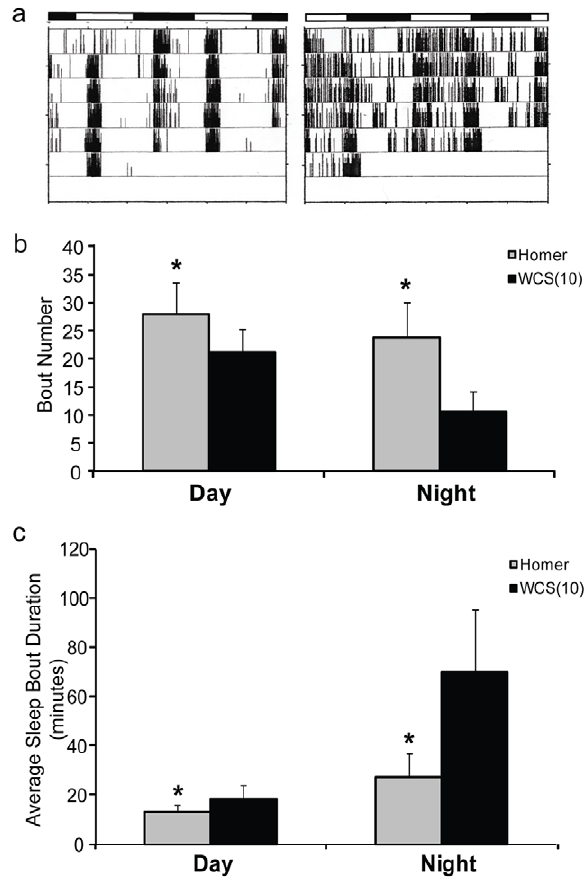
Figure 1. Loss of Drosophila Homer alters sleep architecture. A) Representative actograms displaying activity in homer R102 (right panel) and CS (left panel) flies under a 12:12 L:D regimen. Bar at the top denotes light and dark periods. B) The average number of sleep bouts and standard deviation during the day and night in Homer R102 (gray bar; n=47) and the wildtype CS flies (black bar; n=65) as determined by video analysis. The average number of sleep bouts are significantly greater in homer flies (*p , 0.0001). C) Histogram showing the average sleep bout duration and standard deviation during the day and night in Homer R102 (gray bar; n=47) and the wildtype CS flies (black bar; n=65) as determined by video analysis. The average sleep bout is significantly shorter in homer flies (*p , 0.0001). This difference is particularly marked at night.